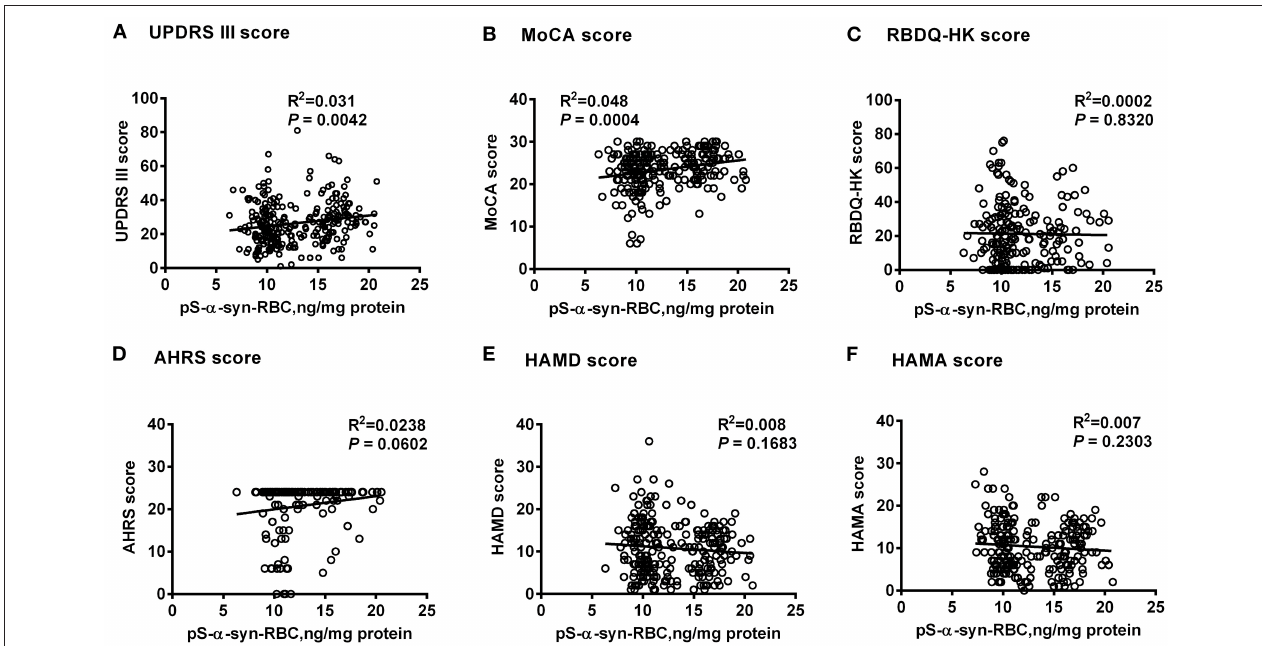
FIGURE 2 | Correlations between pS- α -syn-RBC and scores for motor and non-motor symptoms of Parkinson’s disease. Correlations between pS- α -syn-RBC levels and scores for motor and non-motor symptoms were investigated using multivariate linear regression model adjusting age, sex, and disease duration. pS- α -syn-RBC, phosphorylated α -syn in red blood cells; (A) UPDRS III, Unified Parkinson’s disease Rating Scale part III (motor); (B) MoCA, Montreal Cognitive Assessment; (C) RBDQ-HK, Rapid eye movement (REM) sleep behavior disorder questionnaire-Hong Kong; (D) AHRS, Hyposmia rating scale; (E) HAMD, Hamilton Depression Scale; (F) HAMA, Hamilton Anxiety